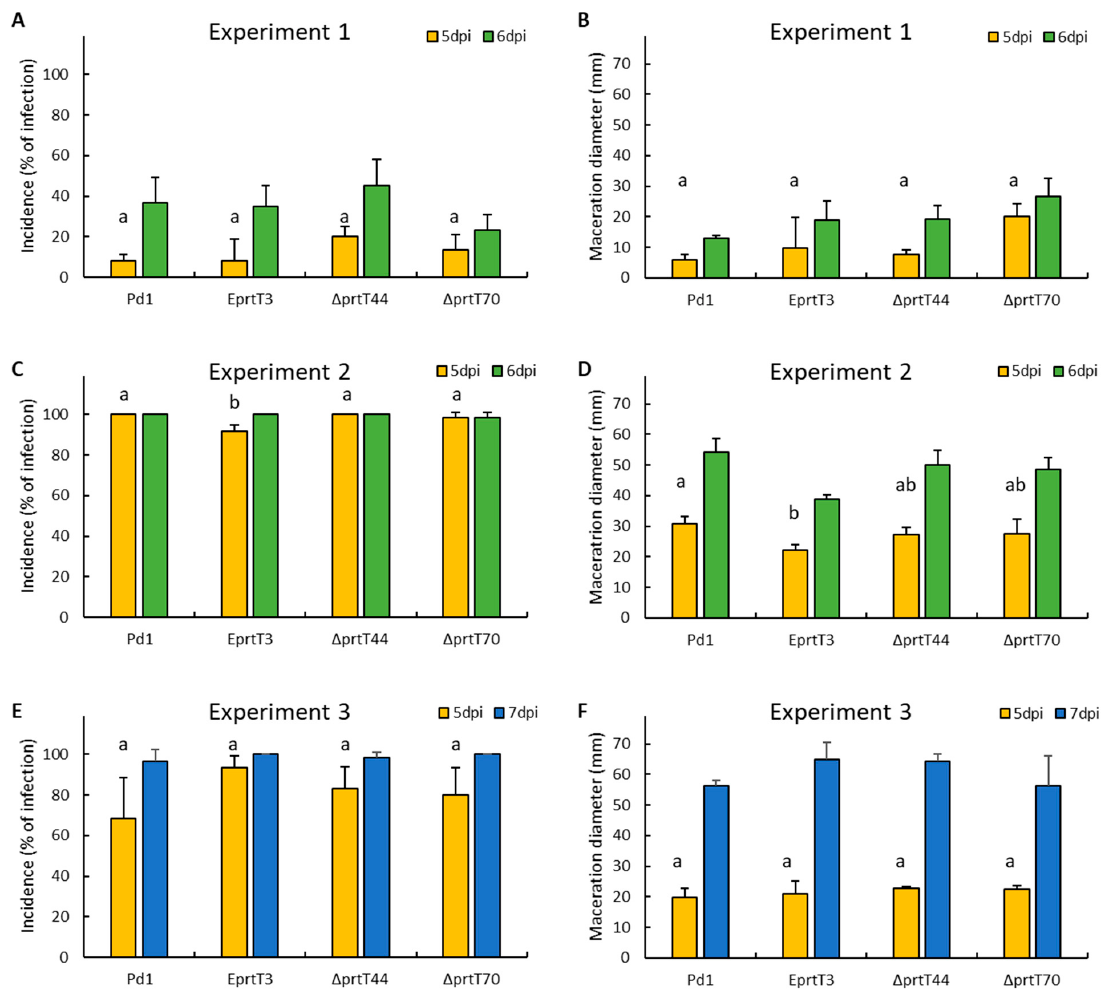
Figure 3. Three independent virulence assays of P. digitatum strain Pd1, the ectopic e prtT 3 mutant, and the two knockout Δ prtT 44 and Δ prtT 70 mutants towards citrus fruit. Navelate ( A and B ) and Lane late ( C to F ) oranges were wounded and inoculated with 10 μ L of a spore suspension (10 4 conidia/mL) of the different strains. Fruits were incubated at 20 °C and 90% relative humidity for up to 7 days. There were three replicates of five fruits and four wounds per fruit. Bars show the mean values of the incidence as the percentage of infected wounds ( A , C , and E ) and the maceration diameter in mm ( B , D , and F ), and their standard deviations at 5 and 6 to 7 days post-inoculation (dpi). Bars labeled with the same letter at 5 dpi do not differ at the 95% confidence level based on the Tukey’s test.